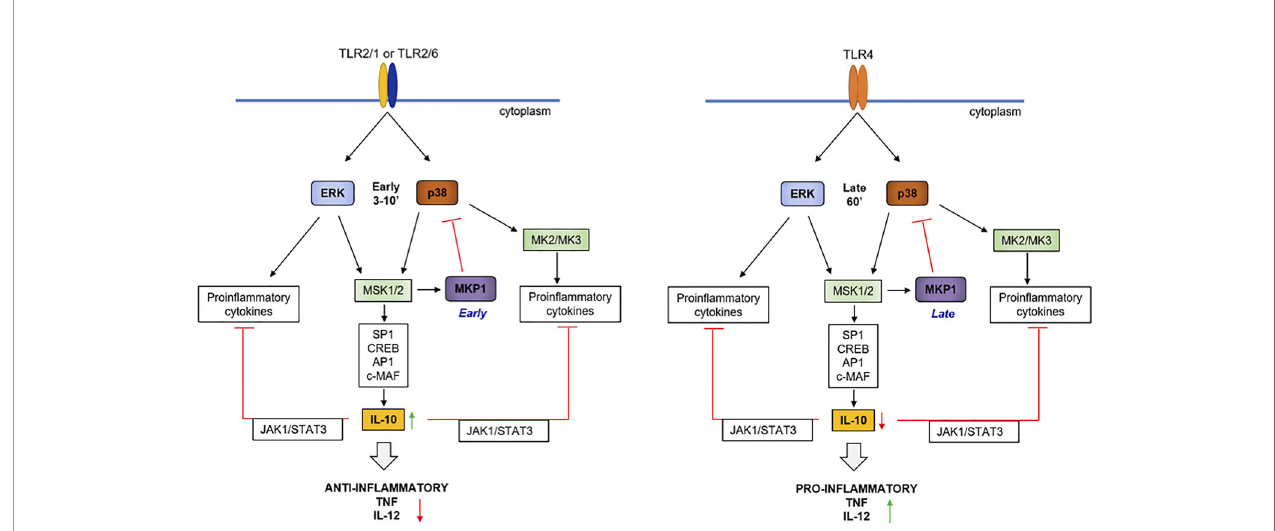
FIGURE 7 | Hypothetical model of the molecular events leading to high IL-10 levels in response to TLR2 ligands. TLR2 ligands such as Pam3CSK4 or FSL-1 activate NF- k B, ERK and p38 earlier and faster ( ≈ 3 min) compared to LPS ( ≈ 30-60 min), allowing a faster induction of cytokines such as TNF- a , IL-12, IL-6 and IL-10 by ERK. The earlier induction of MKP-1 by TLR2 activation contributes for upregulation of pro-in fl ammatory cytokines and MKP-1 can dephosphorylate p38. On the other hand, the early TLR2-mediated p38 induction contributes for later and high IL-10 levels of expression through activation of transcription factors such as SP1, CREB, AP1 and c-MAF. Consequently, IL-10 activates the STAT3 pathway, which ampli fi es IL-10 production and regulates pro-in fl ammatory cytokine